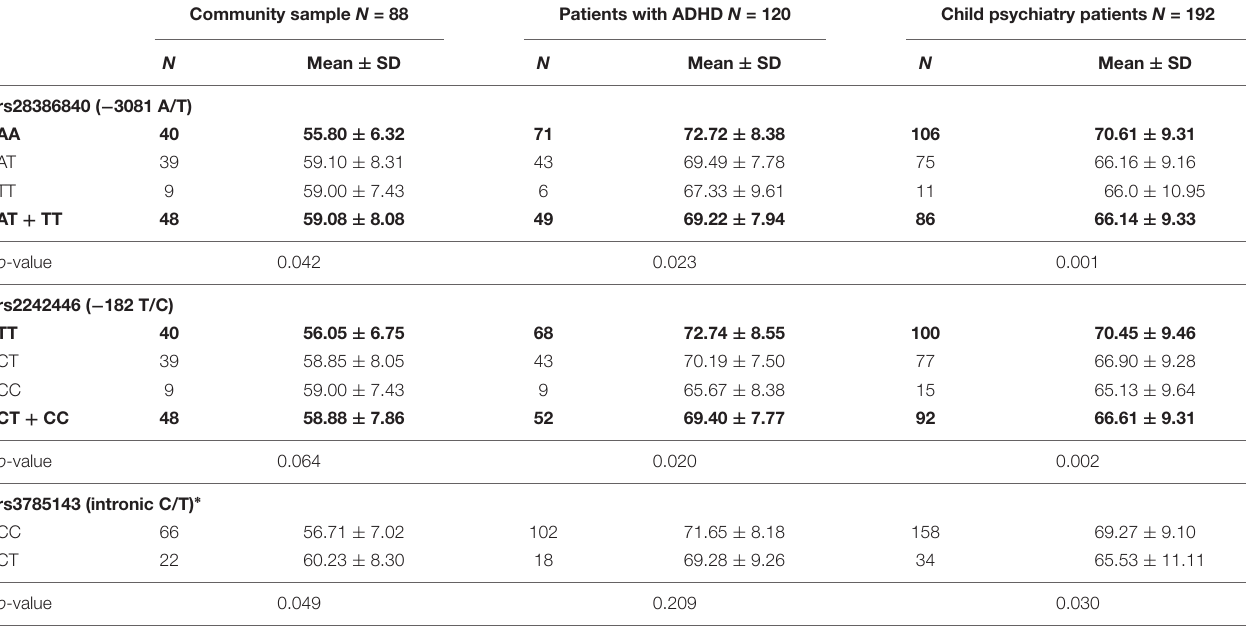
TABLE 1 | CBCL attention problems scores according to the NET genotypes in the community and clinical samples. Community sample N = 88 Patients with ADHD N =